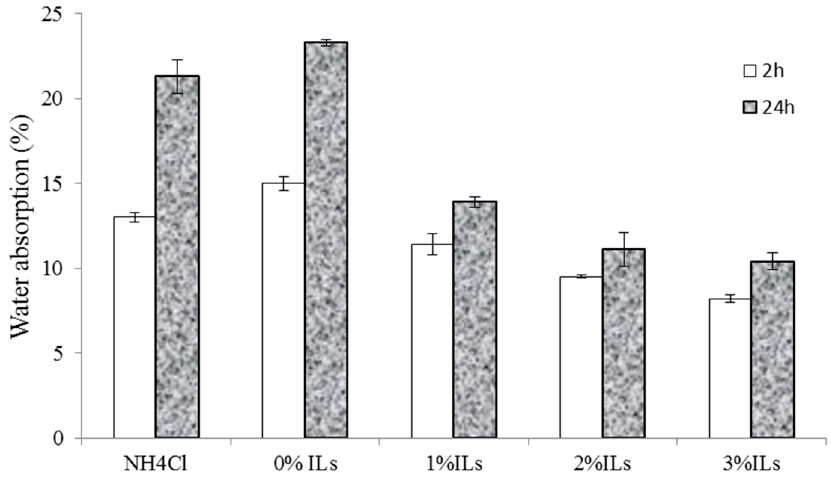
Figure 7. Water absorption of the manufactured panels made from synthesized resins.